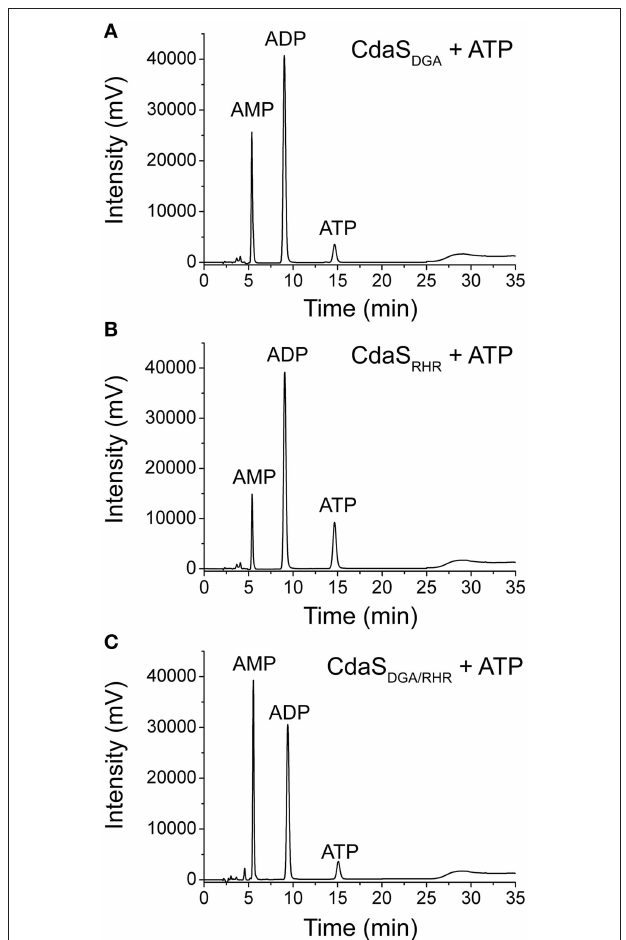
FIGURE 4 | Effect of DGA (A) and RHR (B) motifs alone and both motifs (C) on the DAC and ADPase activities of CdaS. 1 µ M of the three CdaS mutants (CdaS DGA , CdaS RHR , and CdaS DGA / RHR ) were individually incubated with standard reaction mixture at 37 ◦ C in a 100 µ L reaction volume for 8h and analyzed by